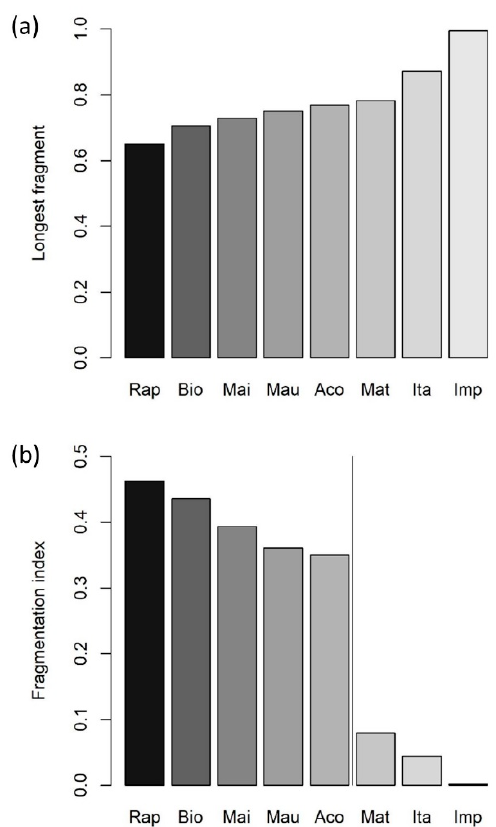
Figure 2. Fragmentation gradient based on ( a ) Longest fragment and ( b ) Fragmentation index values for eight studied basins. Vertical line shows the inflection point used to determine high and low fragmented basins categories. Aconcagua (Aco), Maipo (Mai), Rapel, (Rap), Mataquito (Mat), Maule (Mau), Itata (Ita), Biobío (Bio), and Imperial (Imp). The diversity of native species showed significant differences between river basins with high and low levels of fragmentation (Figure 3). Specifically, species richness ( p = 0.021) and Shannon diversity ( p = 0.008) in pools, as well as total abundance ( p = 0.039) in riffles, were significantly lower in highly fragmented river basins (Figure 3). In contrast, pools in highly fragmented basins exhibit higher values of species richness, total abundance, and Shannon diversity of non-native fish assemblages, however, these differences were not statistically significant (Figure